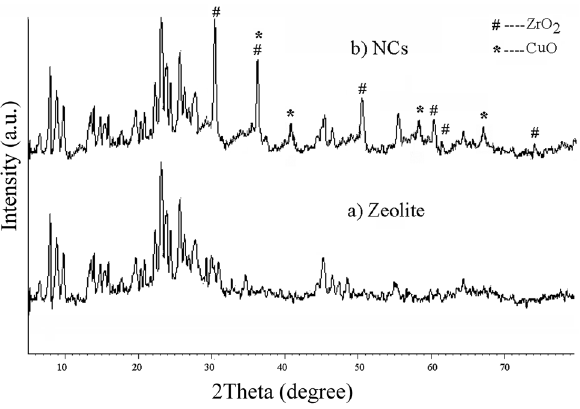
Figure 4. XRD pattern of ( a ) zeolite and ( b ) zeolite-zirconia-copper nanocomposites (NCs).